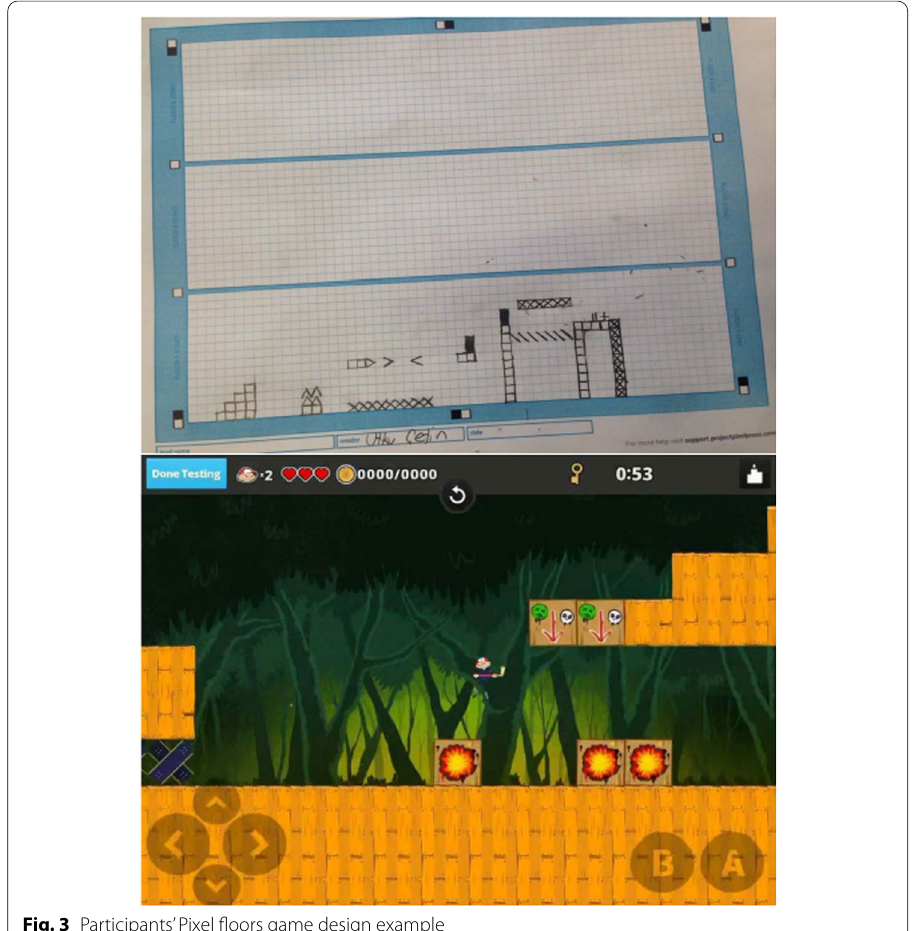
Fig. 3 Participants’ Pixel floors game design example